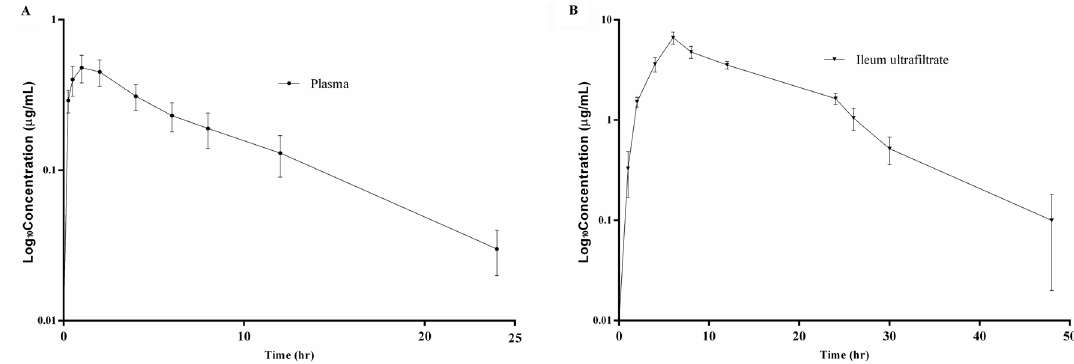
Figure 2. Semi-logarithmic plot of concentration–time profile of plasma at 0, 0.25, 0.5, 1, 2, 4, 6, 8, 12 and 24 h ( A ) and ileum ultrafiltrate at 0, 1, 2, 4, 6, 8, 12, 24, 26, 30 and 48 h ( B ) after DAN i.m. administration at a dose regimen of 2.5 mg/kg in piglets. Values are means ± SD (n = 6).